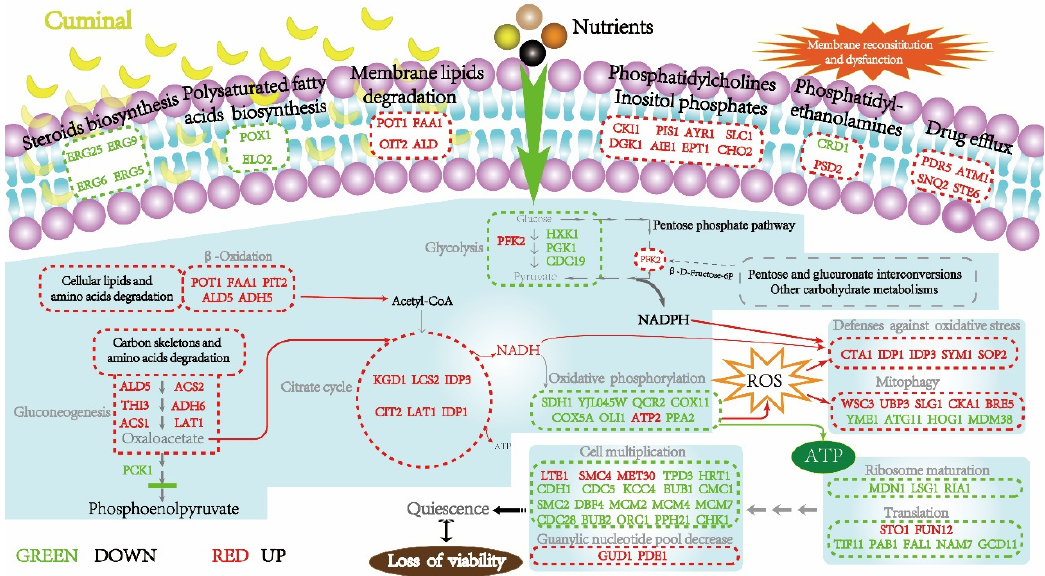
Figure 12. Proposed mode of action of cuminal against T. roseum . Red color in the diagram shows up regulation of genes or overall elevation of the indicated metabolic blocks while green color indicates down regulation of genes or overall suppression of a metabolic bock. The metabolism blocks that were deeply analyzed in the text are circled with red or green dash lines.